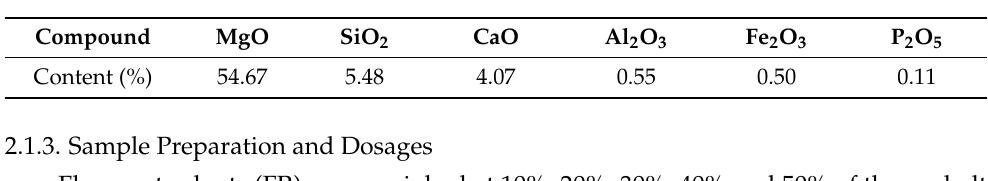
Table 3. FR composition analysis using X-ray